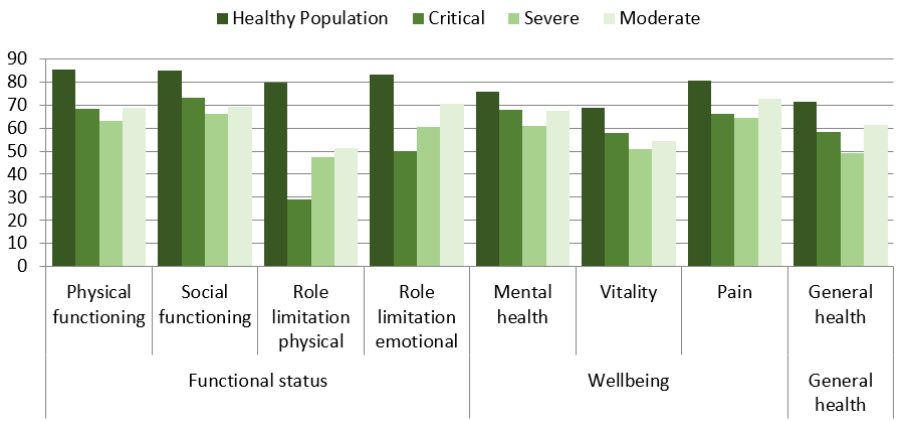
Figure 3. HRQoL results for groups with different disease severity and the general (healthy) population.